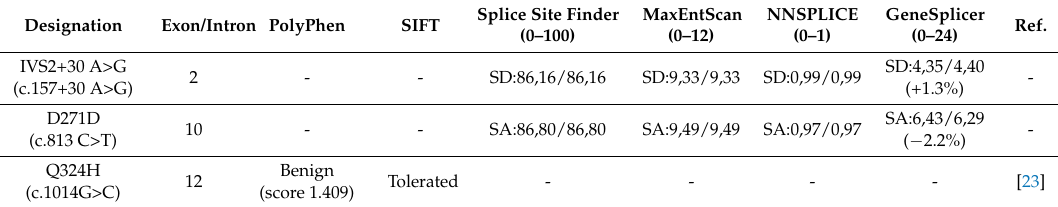
Table 1. In silico study of MUTYH variants. The thresholds represent the score predicted for wild type sequence/score predicted for the mutated sequence. Scores indicate the values for splice donor (SD) or splice acceptor (SA) sites, respectively. Changes relative to wild type sequences are indicated in %.